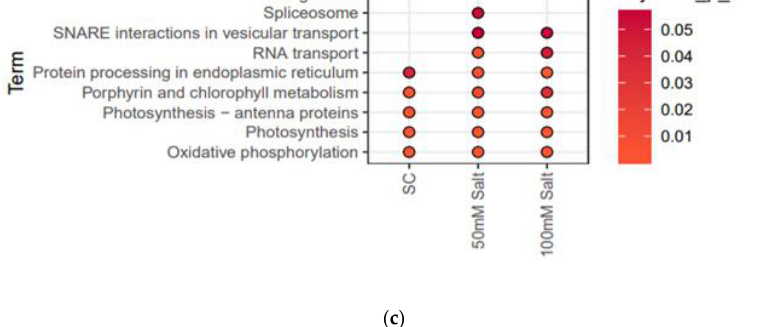
brane components, and 20 proteins associated to the SNARE complex, photosystem I and chloroplast envelope (Figure 4c). The predominant domains in our membrane proteomes were P-loop-containing nucleoside triphosphate hydrolases, AAA + ATPases, small